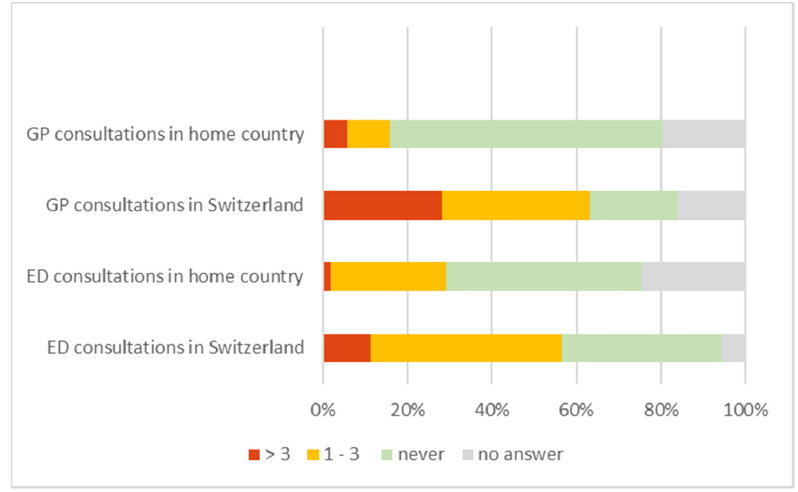
Figure 3. Chart of general practitioner (GP) and emergency department (ED) consultations of AS in their home country and in Switzerland, numbers in %.